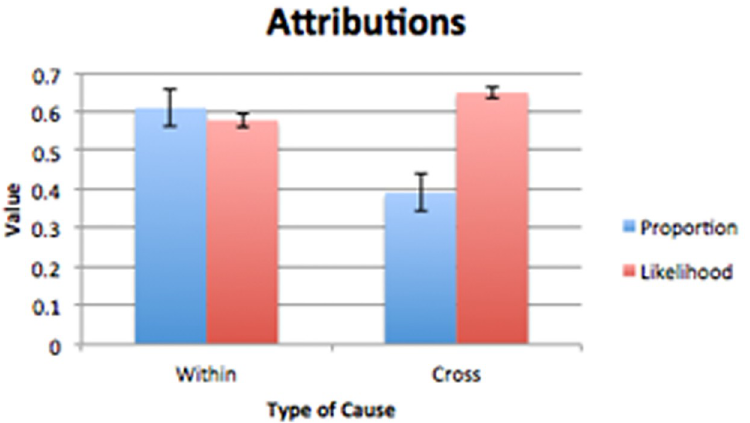
Fig 5. Proportion of attributions (within and cross proportions sum to 1) and mean likelihoods for causes that matched the domain of the effect (within-domain) vs. those that did not (cross-domain). (Error bars are 95% Confidence Intervals for the proportions).